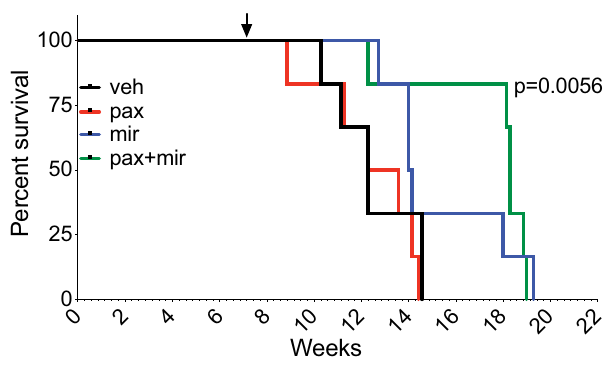
Fig. 9 Combined treatment with paxalisib and mirdametinib signi fi cantly extends survival of SJ-DIPGX37-bearing mice. Mice were randomized 50 days after implantation into four treatment arms (6 mice per arm) and treated with vehicle (black), paxalisib (8 mg/kg) (red), mirdametinib (14 mg/kg) (blue), or paxalisib + mirdametinib daily (green), 5 days ON and 2/ 3 days OFF. Paxalisib + mirdametinib vs. vehicle, p = 0.0056; mirdametinib vs. vehicle, p = 0.16; paxalisib vs. vehicle, p = 0.48 (Mantel – Cox log-rank test). Arrow shows the time point for randomization and initiation of treatment. Kaplan – Meier survival